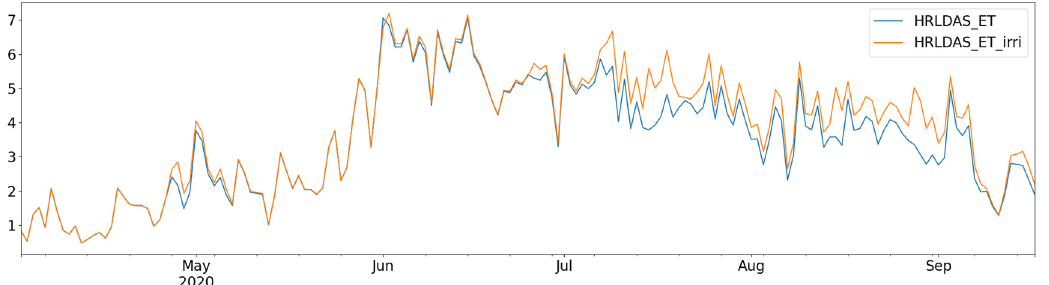
Figure 11. HRLDAS ET with and without in situ irrigation information incorporated in the 2020 growing season, averaged over three sites inside Nebraska.